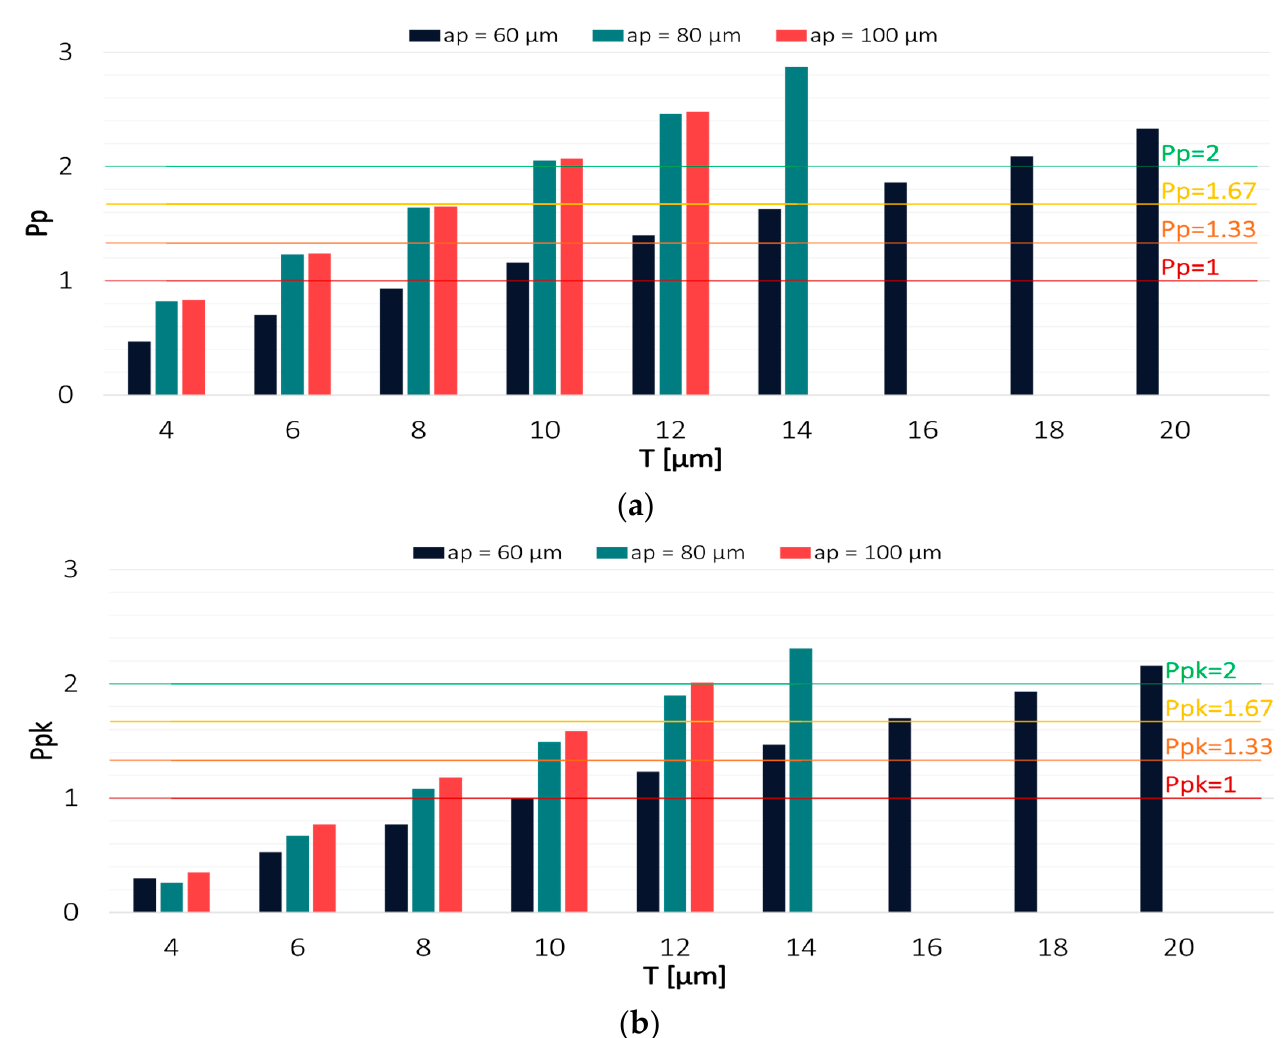
Figure 8. Values of ( a ) Pp and ( b ) Ppk for the results obtained in a milling process conducted with variable feed per tooth and TiAlN-coated tool.